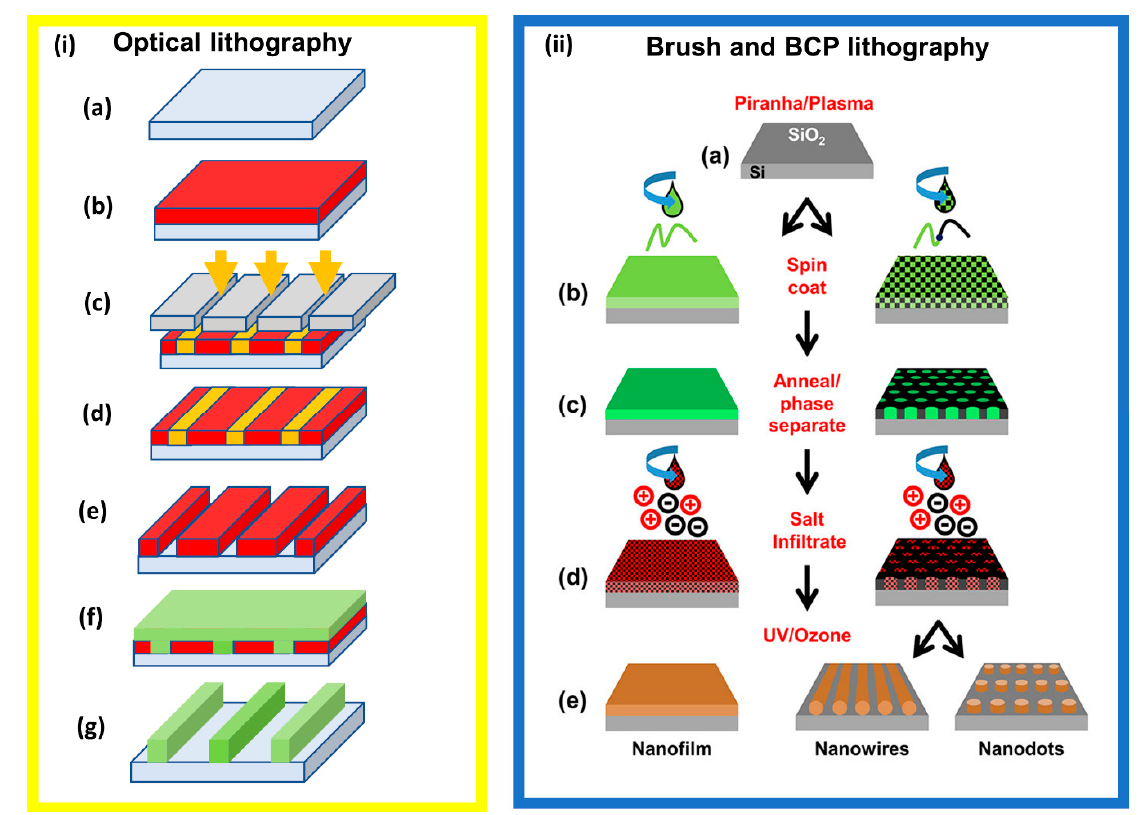
Figure 4. Comparison of ( i ) optical lithography and ( ii ) brush and BCP lithography. The first stage for both these processes is ( a ) substrate cleaning. The basic steps for optical lithography illustrated in Figure 4 part ( i ) and consist of, ( b ) photoresist deposition, ( c ) UV exposure, ( d ) post-baking, ( e ) development, ( f ) metal thin film deposition, and ( g ) polishing and etching [150]. The principal steps for Brush and BCP lithography of polymers are shown in Figure 4 part ( ii ) and comprise of ( b ) polymer spin casting, ( c ) annealing/phase separation, ( d ) salt infiltration, and ( e ) UV/ozone [18]. Reprinted (adapted) with permission from ([18]). Copyright (2010) American Chemical Society.